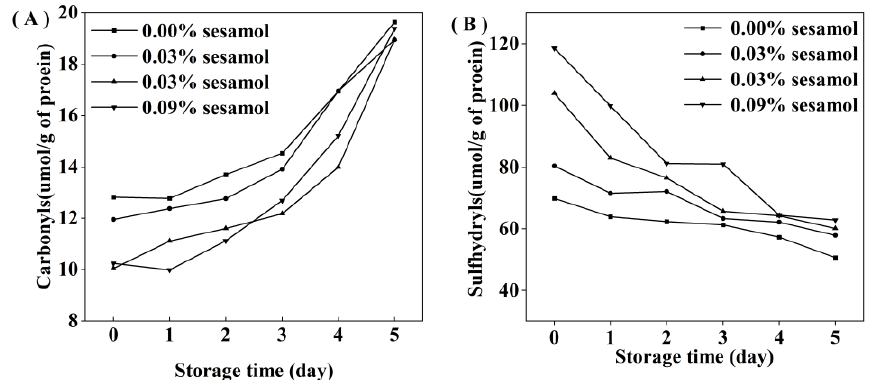
Figure 4. Effect of different sesamol concentrations on protein sulfhydryl ( A ) and carbonyl ( B ) groups in emulsions during storage (30 mL of emulsion in a 50 mL glass bottle with screw cap stored at room temperature and protected from light).